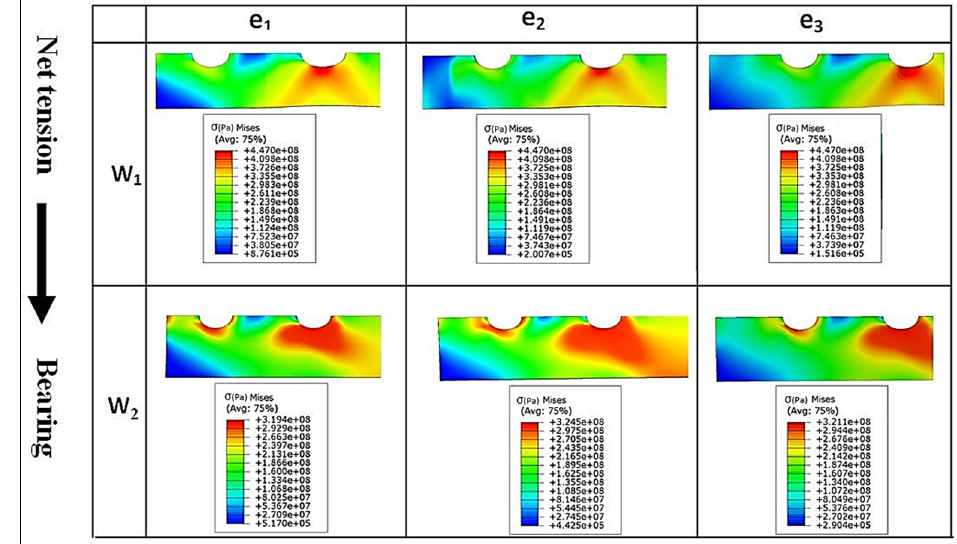
Figure 9. Von Mises stress (Pa) contours in the middle plate of double bolt joint specimens with different widths ( W 1 and W 2 ) and edge distances ( e 1 , e 2 , and e 3